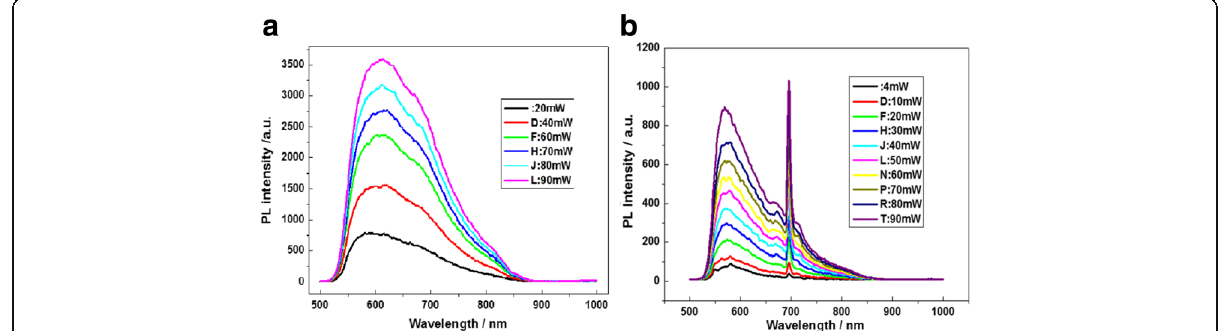
Fig. 4 a PL spectra with excitation power measured at room temperature on the sample I prepared in vacuum. b PL spectra with excitation power measured at room temperature on the sample I after